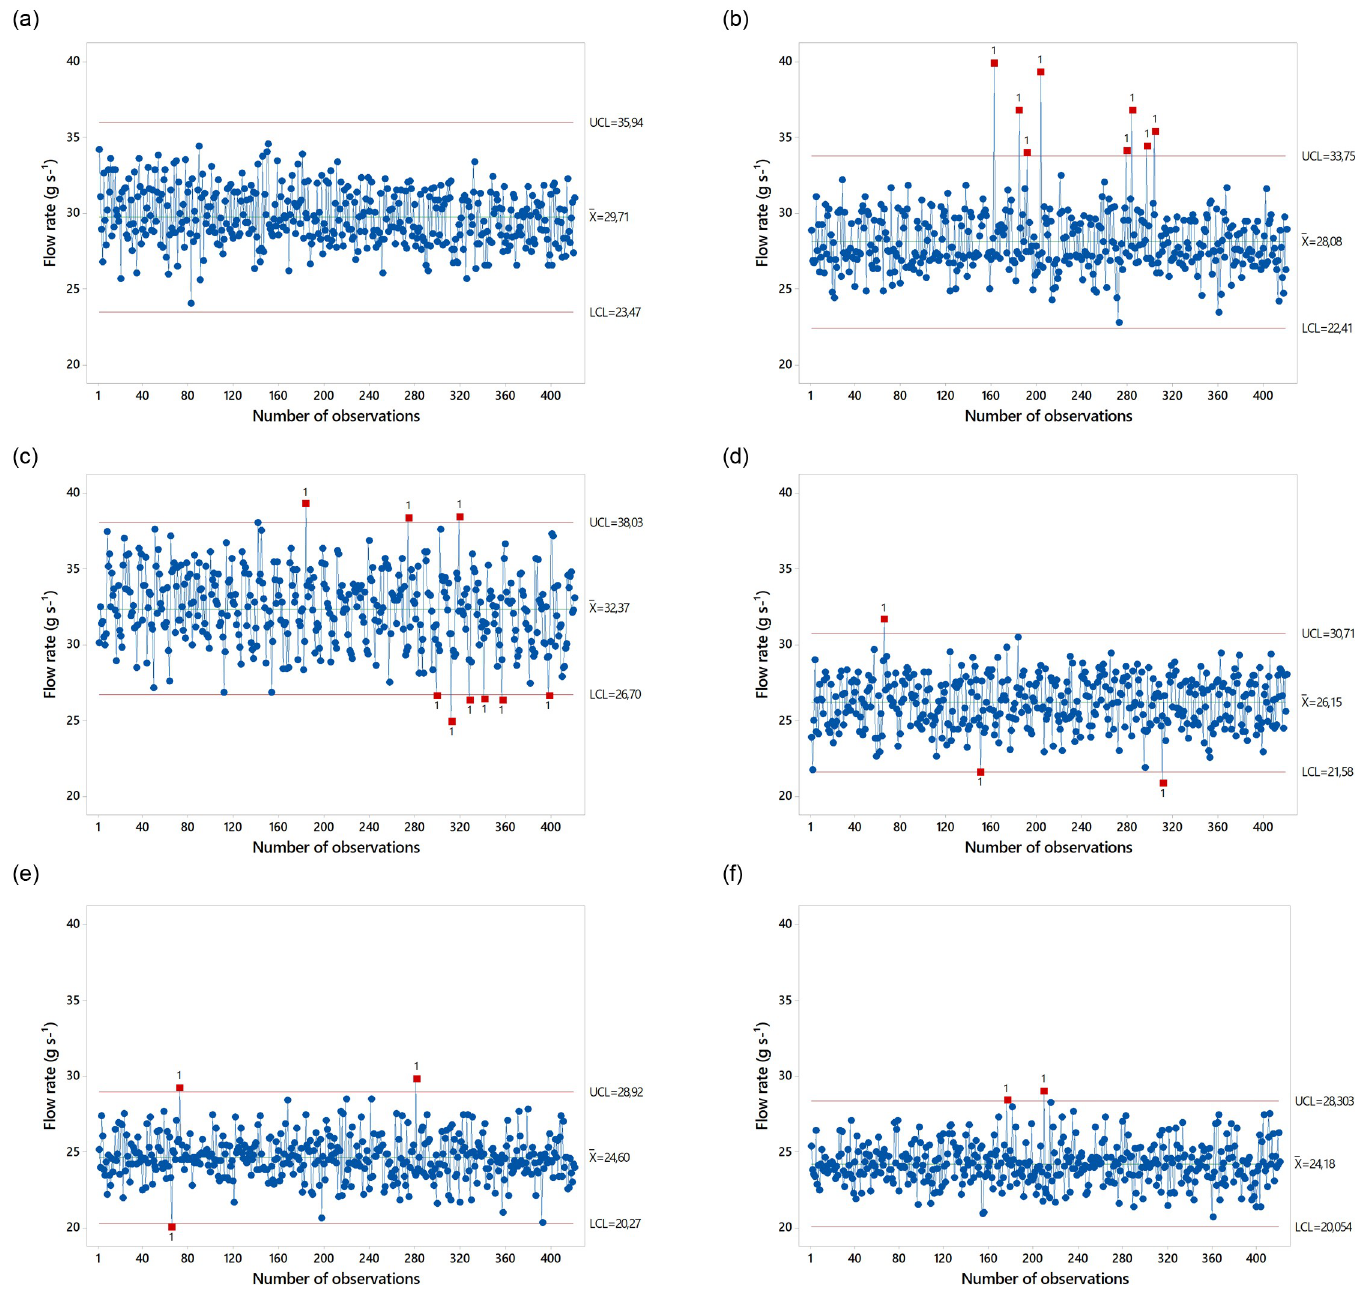
Fig 5. Performance of fertilizer spreaders at a speed of 1.94 m s -1